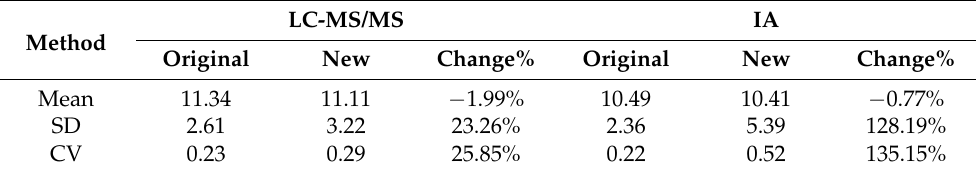
Table 5. Mean, SD and CV of FT4 transformations into ED scale by linear